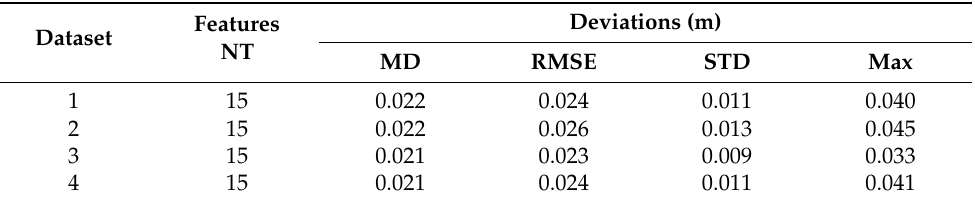
Table 3. Horizontal accuracy. The ‘Dataset’ column represents the dataset index. The ‘Features’ column gives the number NT of the detected points in each dataset. The deviation is calculated as the horizontal distance between the corresponding features from the TLS and UAV data.